Question: State the chart type depicted above.
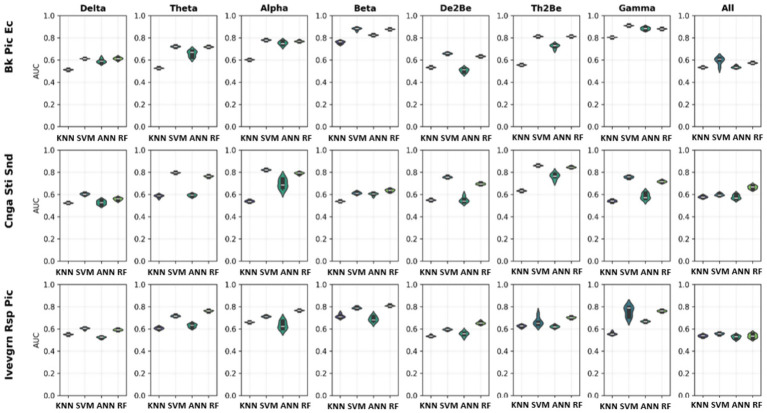
Answer: box